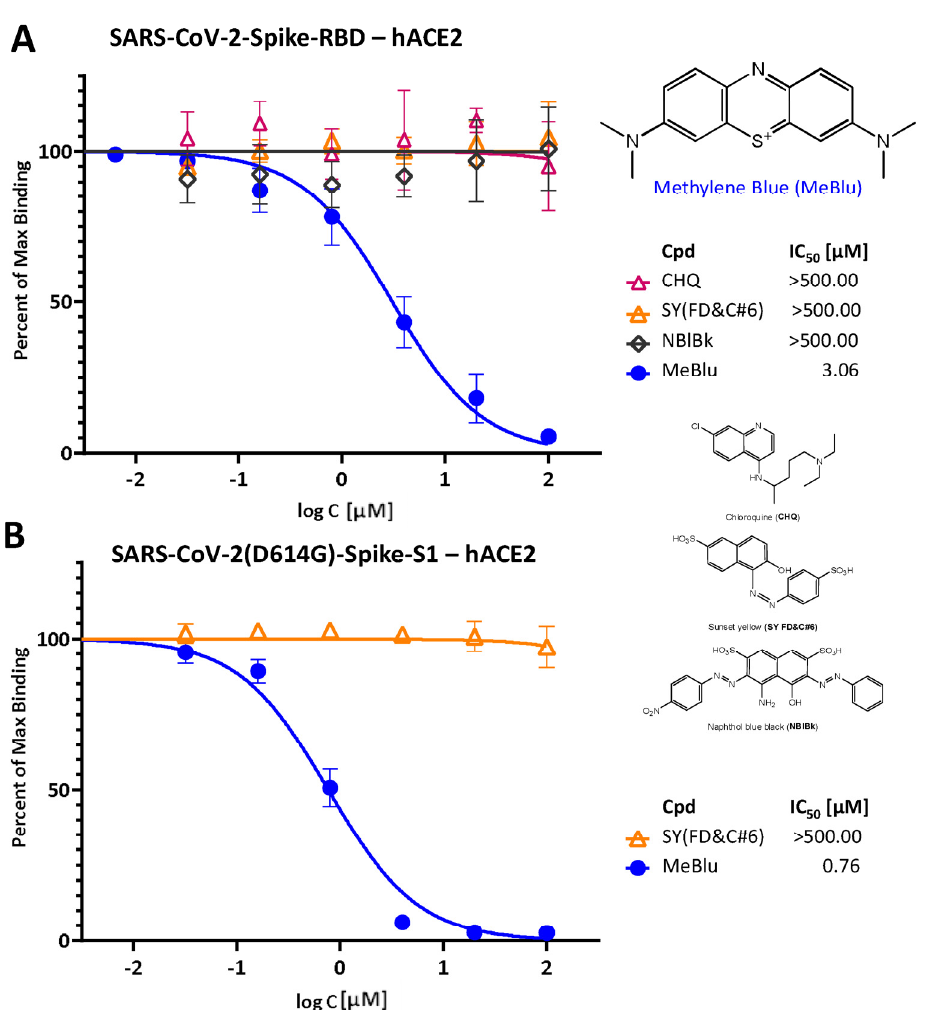
Figure 1. Concentration-dependent inhibition of SARS-CoV-2 spike protein binding to human ACE2 by methylene blue (MeBlu). Concentration–response curves obtained in ELISA-type assay showing the inhibition of the binding of SARS-CoV-2 spike RBD (His tagged) ( A ) and D614G mutant S1 ( B ) to hACE2 in the presence of increasing concentrations of test compounds. Contrary to MeBlu, neither chloroquine (CHQ) nor the two other dyes included as control (sunset yellow FCF, SY and naphthol blue black, NBlBk) showed inhibitory activity (chemical structures shown on the right). Data in ( A ) incorporate measurements from our previous work [23] combined with one confirmatory remeasurement here and are included for reference and comparison purposes. Data (mean ± SD) were normalized and fitted with standard inhibition curves; obtained IC 50 values are shown.